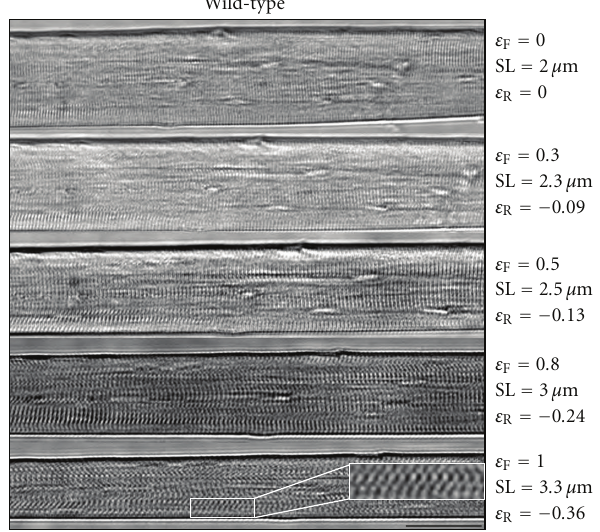
Figure 4: Geometric and structural response of a 10-month-old wild-type fiber to tensile loading. The same region of the fiber, imaged using phase-contrast microscopy, is shown at five di ff erent deformations. Fiber strains, radial strains, and sarcomere lengths are reported to the right of the fiber for each deformation. The fiber displays well aligned Z-lines (dark vertical stripes), consistently increasing sarcomere strain, and decreasing fiber diameter with increased fiber deformation. A sample region of the fiber that displays particularly well aligned Z-lines that are experiencing some shear, inferred through the slanting of Z-lines, is marked with a white box. The boxed region has been computationally enlarged 2x for clarity. At high strains ( ε F > 0 . 8), artifactual thickening of Z- lines occurs due to shear-induced o ff sets of Z-lines in deeper regions of the fiber. Bar = 50 μ m.